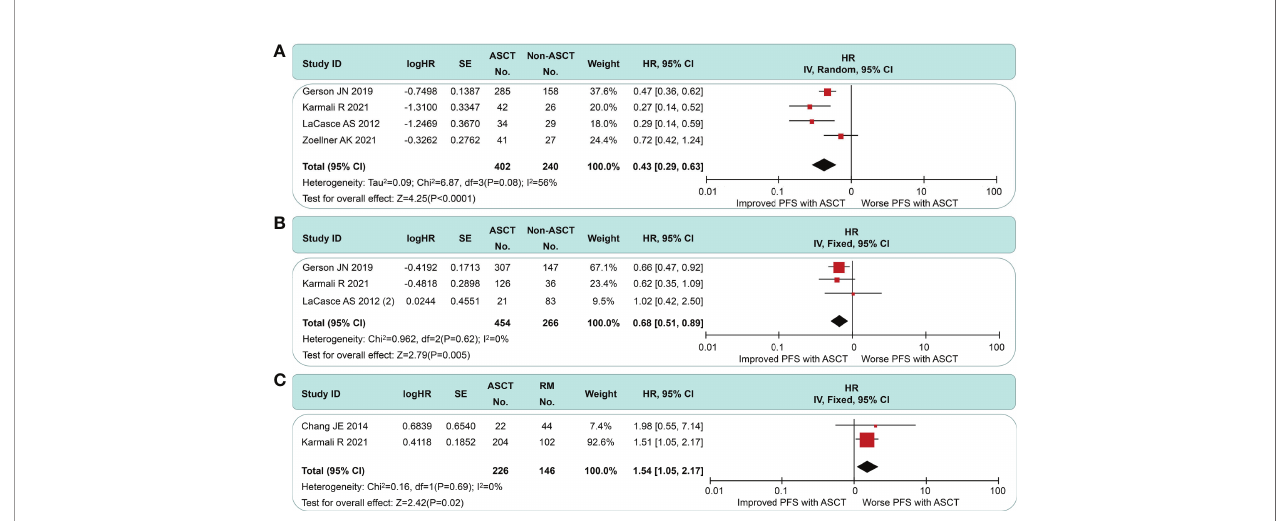
FIGURE 4 | Meta-analysis results of progression-free survival: (A) Subgroup analysis for patients with non-intensive induction. (B) Subgroup analysis for patients with intensive induction. (C) Survival analysis between patients undergoing autologous stem cell transplantation and rituximab.